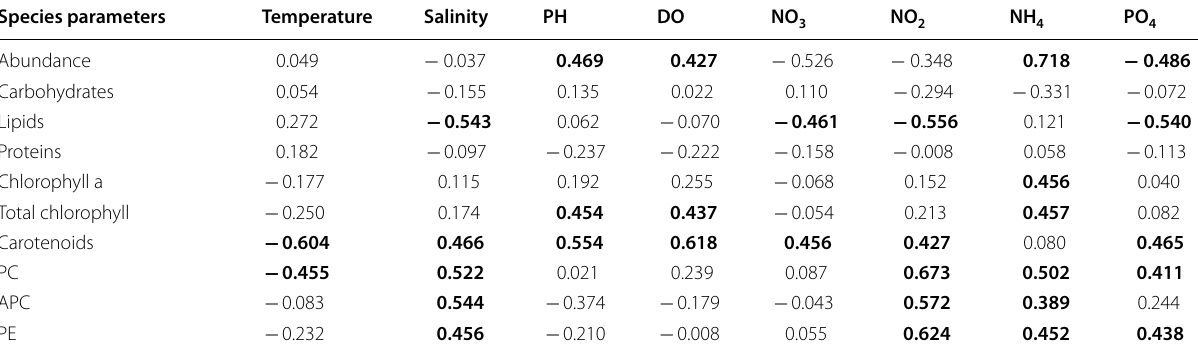
* Bold values are significantly correlation at P < 0.05 level